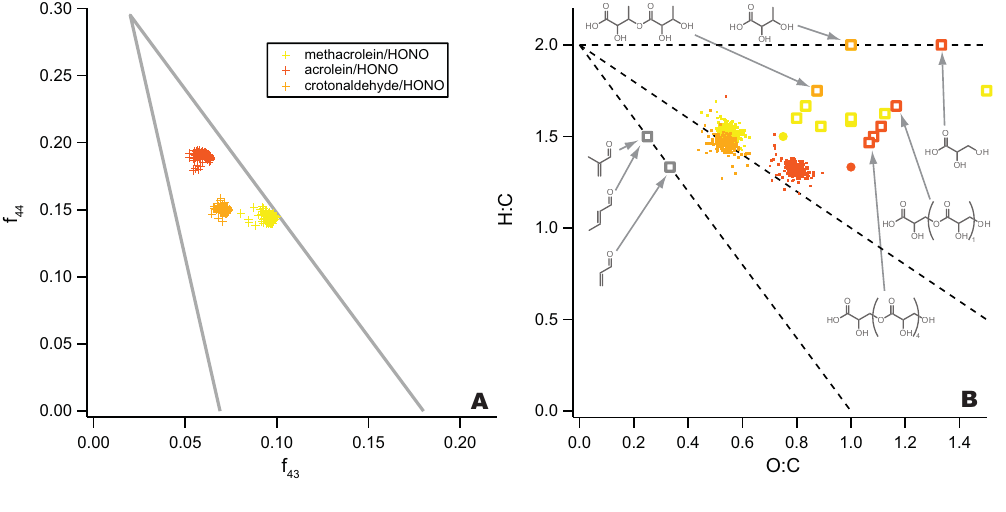
Fig. 7. (A) “Triangle plot” for SOA formed from photooxidation of methacrolein, acrolein, and crotonaldehyde. (B) Van Krevelen diagram for SOA formed from photooxidation of methacrolein, acrolein, and crotonaldehyde. Identified SOA products of each system are presented in boxes of the corresponding color (Chan et al., 2010). Oligomeric limits for each system condition are represented by